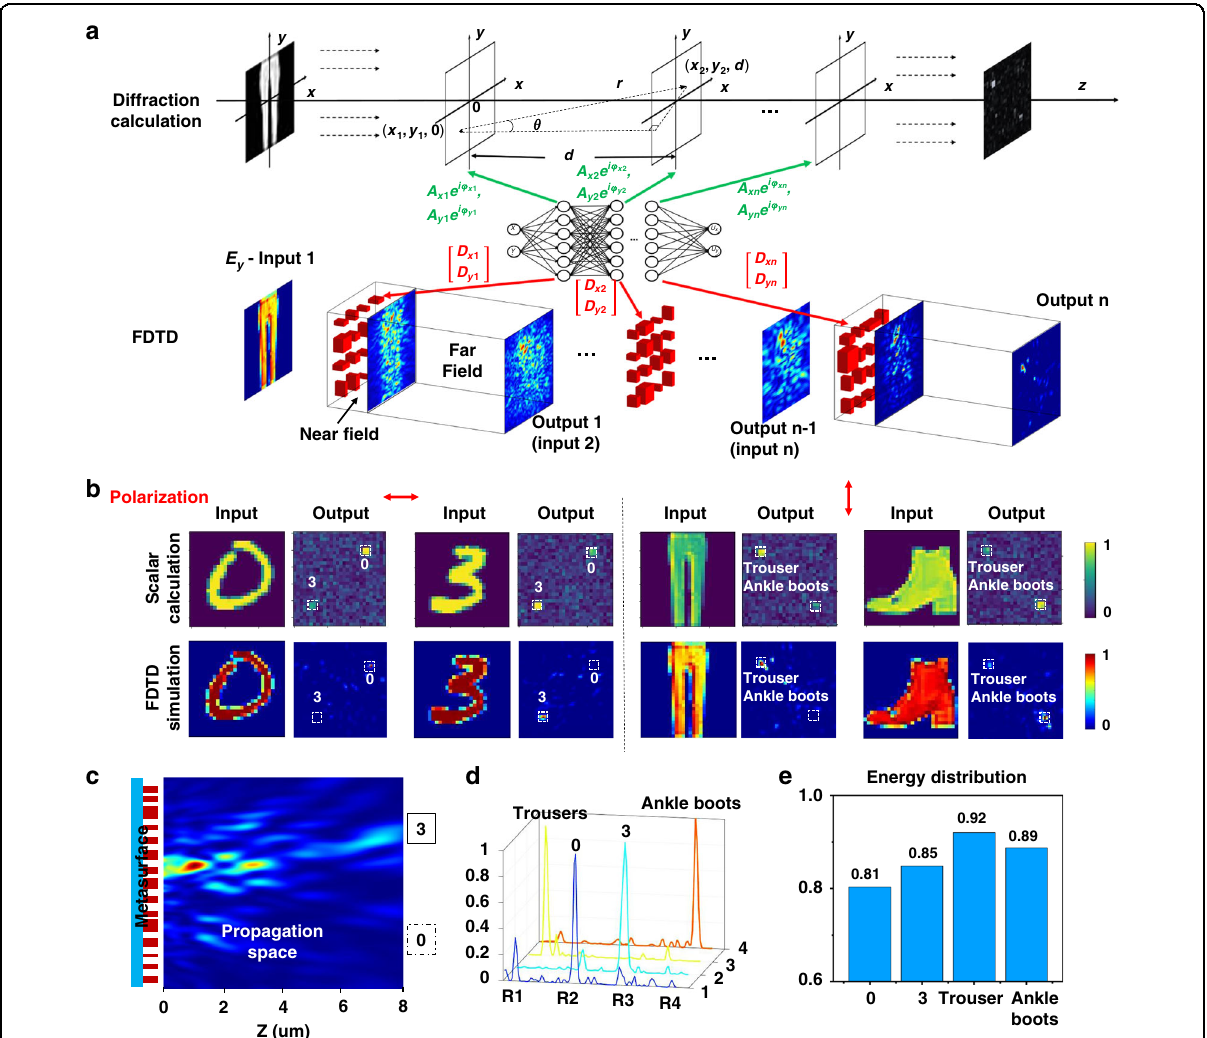
Fig. 3 Vector simulations of multi-layer MDNN. a Flowcharts of scalar diffraction calculation and vector FDTD simulation. b Comparison of simulation results between scalar diffraction calculation and vector FDTD calculation for multi-channel classi fi cation. c The electric fi eld distribution in the z -plane simulated by the handwritten input of “ 3 ” in b demonstrates that the light propagation is focused on the target region. d The output intensity in b is normalized along the x -direction distribution, and the maximum peaks are all con fi ned to the detection region. R region. e The average energy distribution of simulated 10 groups for each of the four types of objects, all of which are randomly selected in the MNIST and Fashion-MNIST datasets, reached more than